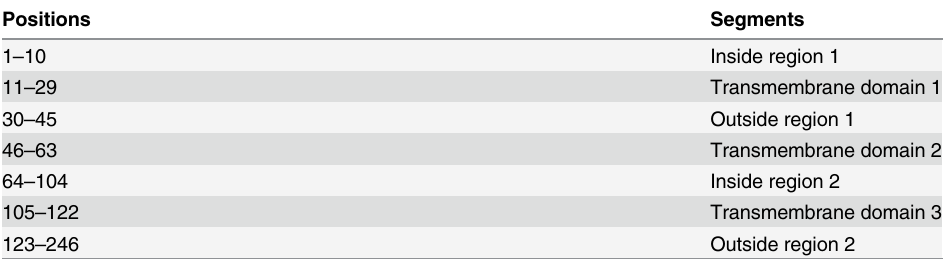
Table 2. Prediction of transmembrane helices and topology of cell surface-expressed BAP31.